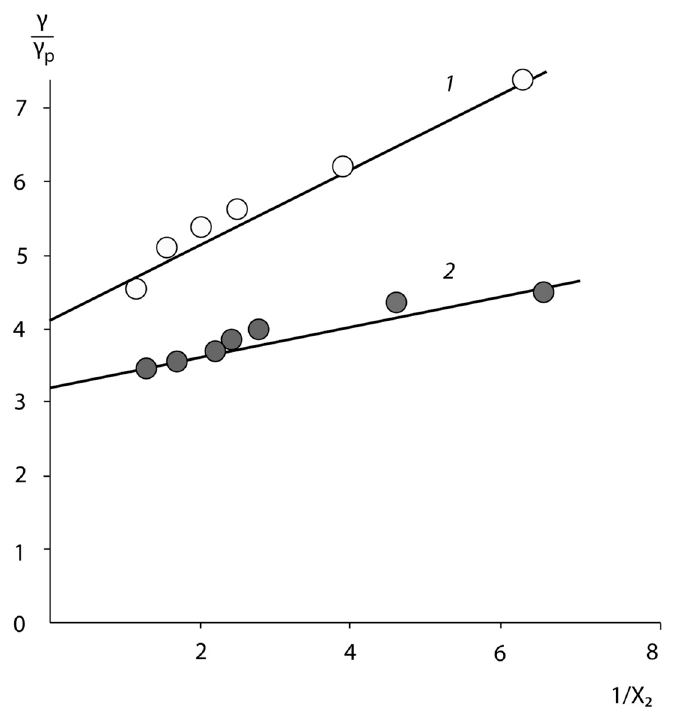
Figure 5. Isotherms of sorption by the polar groups of BNC (1), and vinyl acetate (2) on the Al substrate surface in coordinates with the linear version of the Langmuir equation.